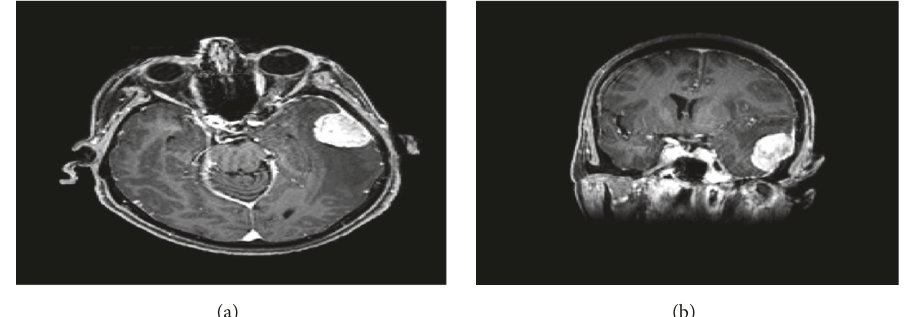
Figure 1: Preoperative magnetic resonant imaging of the brain showing hypertense left-temporal lesion (a) and midline shift and vasogenic edema (b).